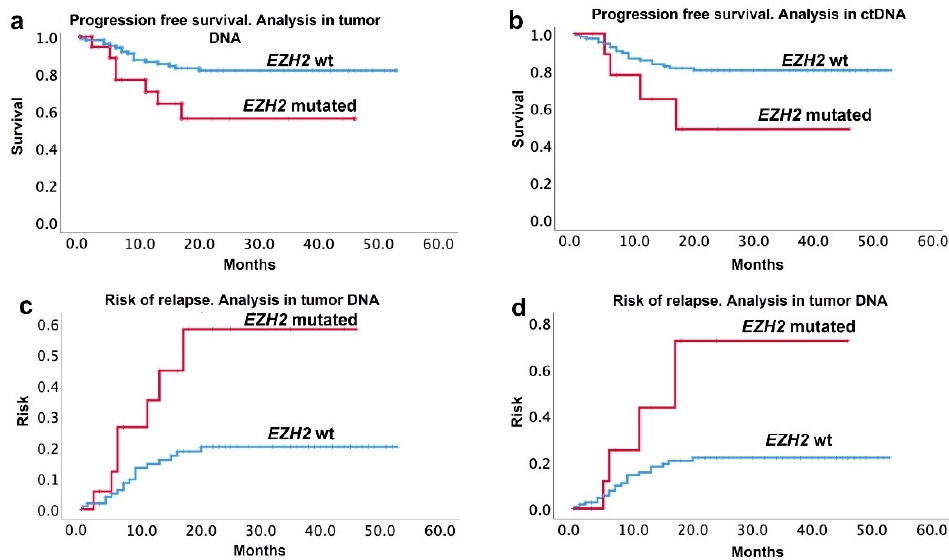
Figure 2. Progression-free survival and risk of relapse curves, according to EZH2 mutation status. Progression-free survival in tumor ( a ) and ctDNA ( b ), and risk of relapse, when analyzing tumor ( c ) and ctDNA by ddPCR ( d ). Blue line = EZH2 wild-type; red line = EZH2 mutated.